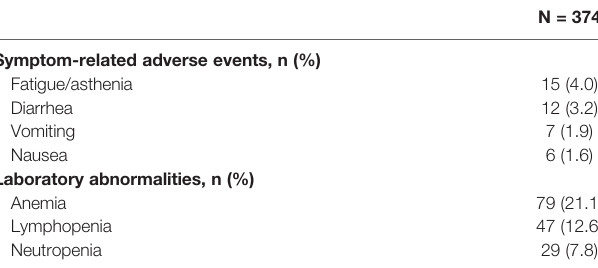
TABLE 5 | Grade 3 or 4 symptom-related adverse events and laboratory